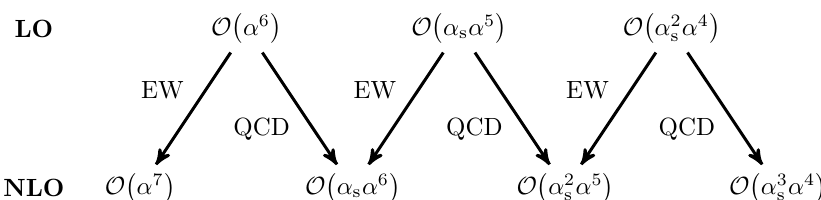
Figure 3. LO and NLO contributions to W + W − scattering and its irreducible background. In this paper, we discuss both the EW and QCD NLO corrections to corrections to the interference process for several experimental